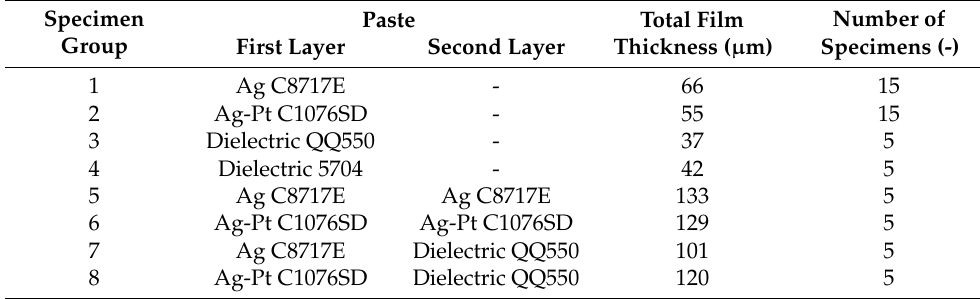
Table 1. Description of test specimen groups.